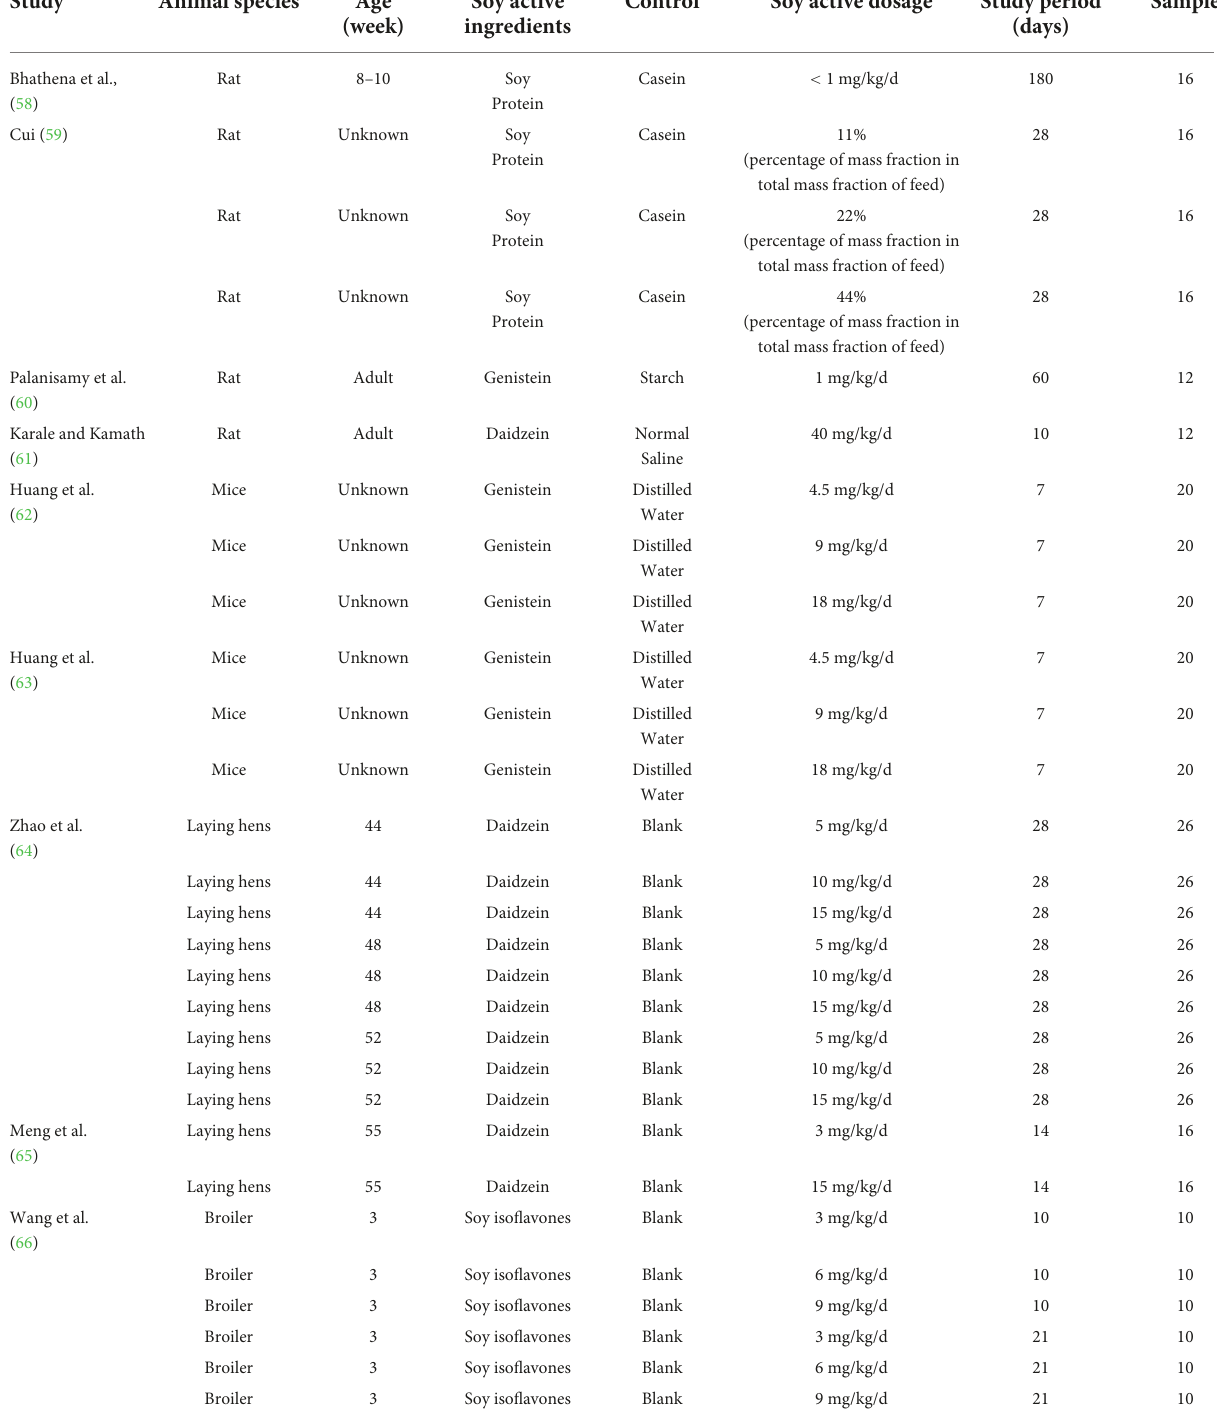
TABLE 3 Characteristics of animal